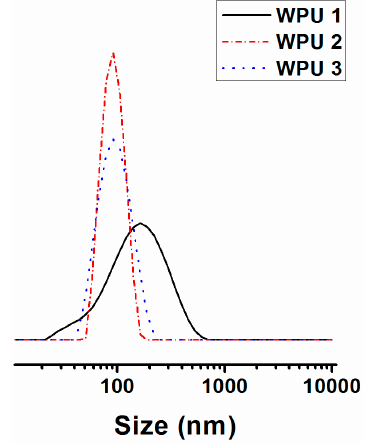
Figure 7. The particle size distribution diagram of the aqueous polyacrylate-based polyurethane by poly( n -butyl acrylate) diol.